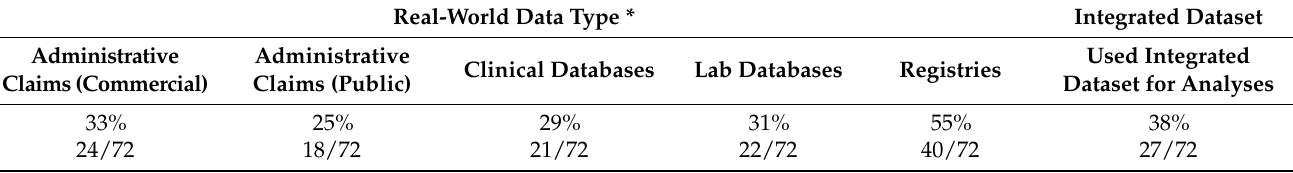
Table 1. Percentage of studies by characteristics ( n = 72).